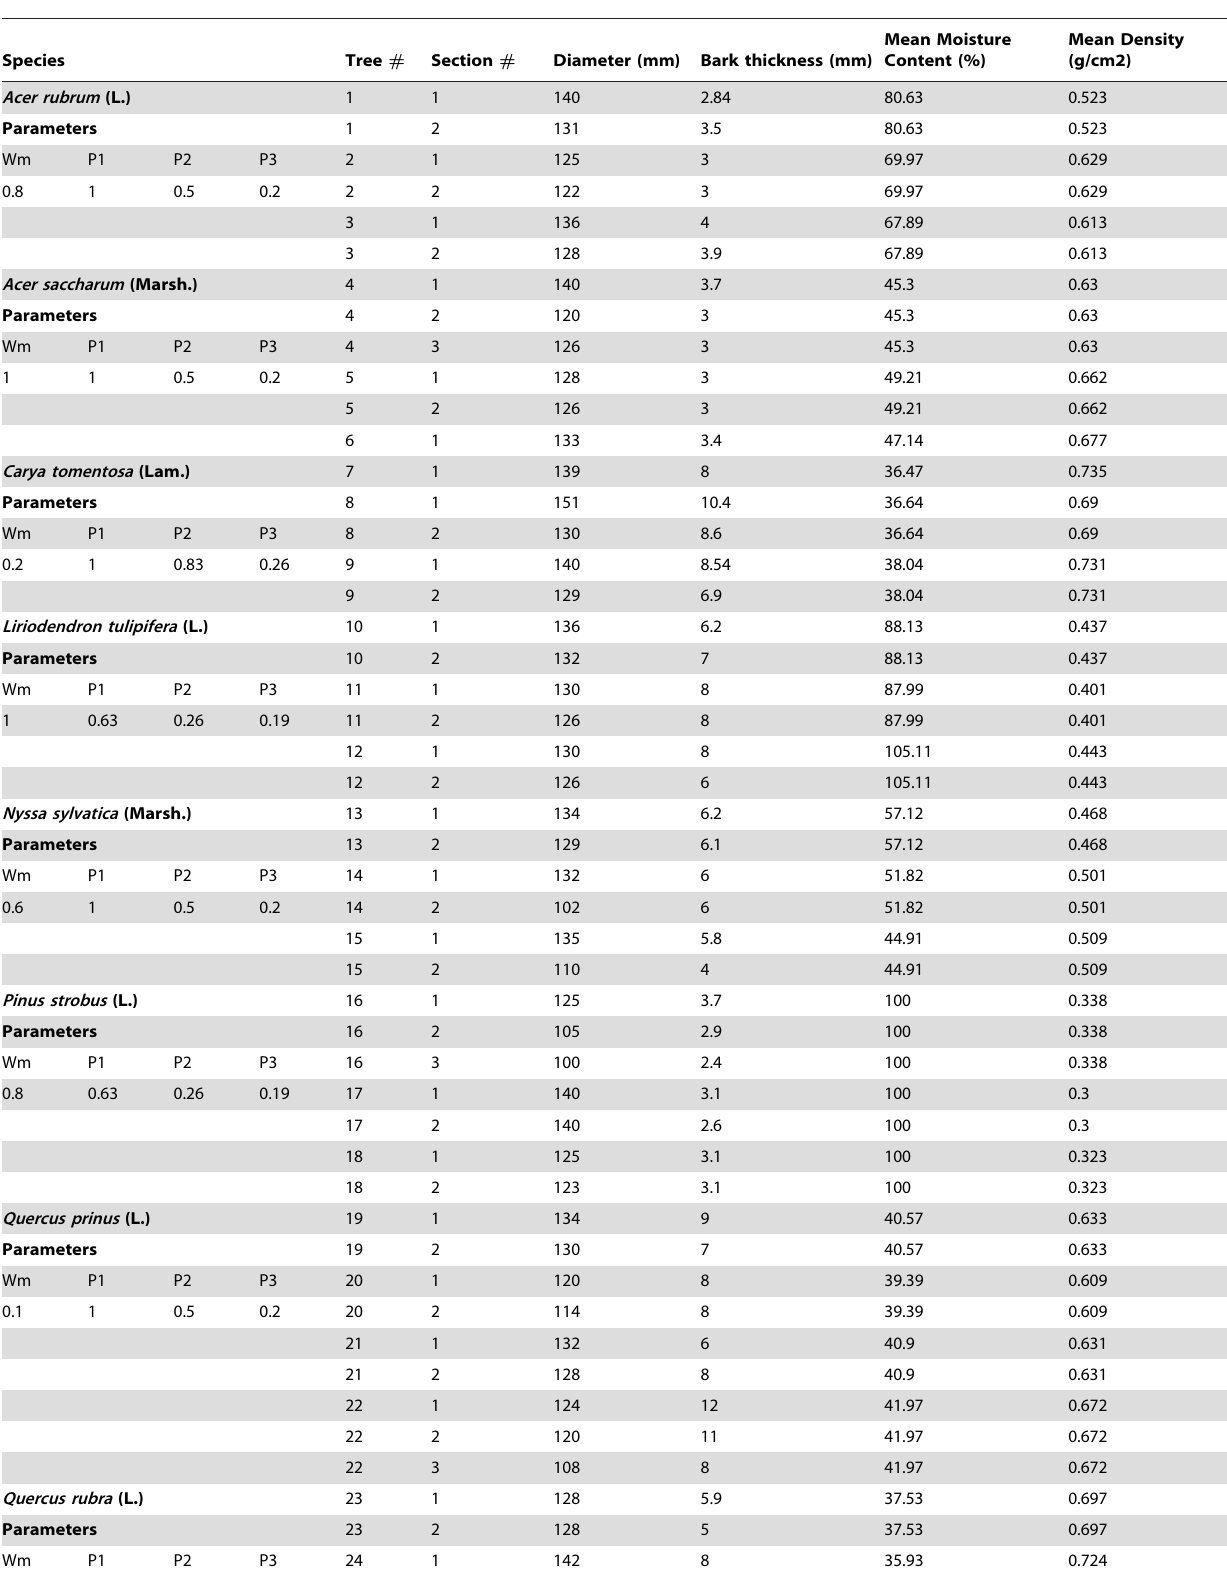
Table 1. Tree species and sections used in the laboratory experiment and parameterization of the thermophysical properties of the species.